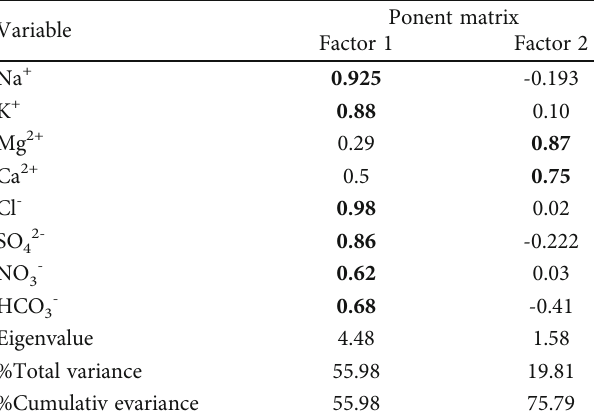
Table 6: Component